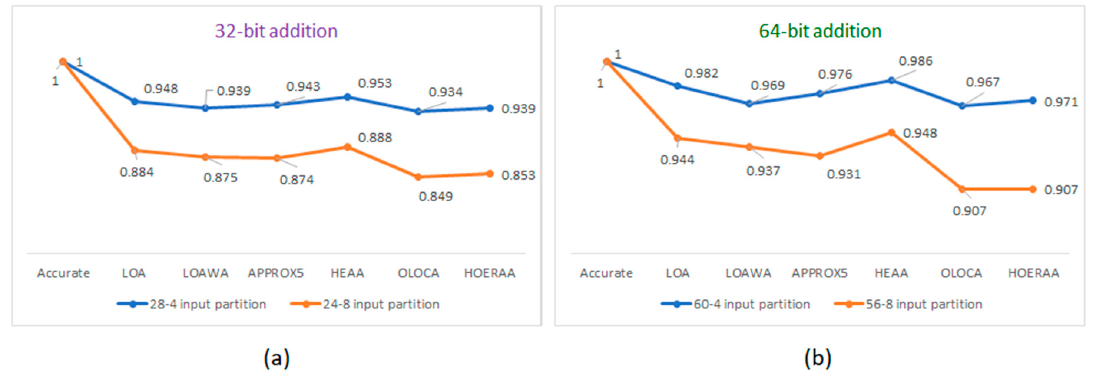
Figure 2. Normalized PDP plots of accurate and approximate FPGA-based adders corresponding to: ( a ) 32-bit addition and ( b ) 64-bit